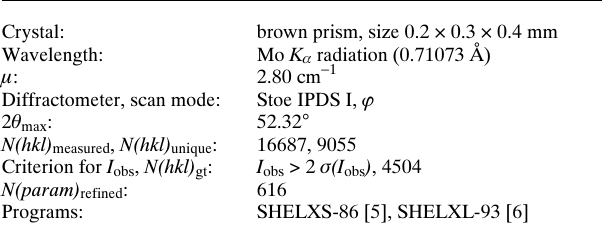
Table 1. Data collection and